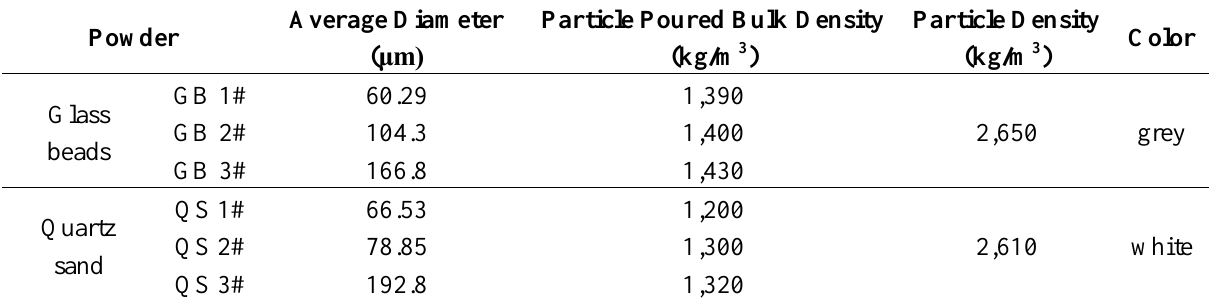
Table 2. Physical properties of